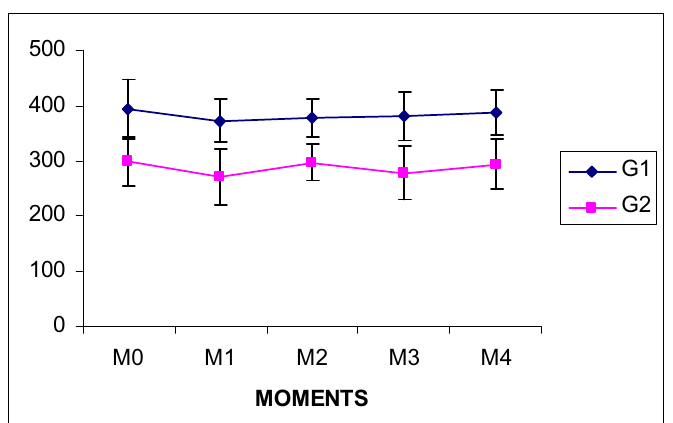
FIGURE 2 - Mean values for serum albumin concentration (g/100ml) of animals in groups 1 and 2 at the experimental moments